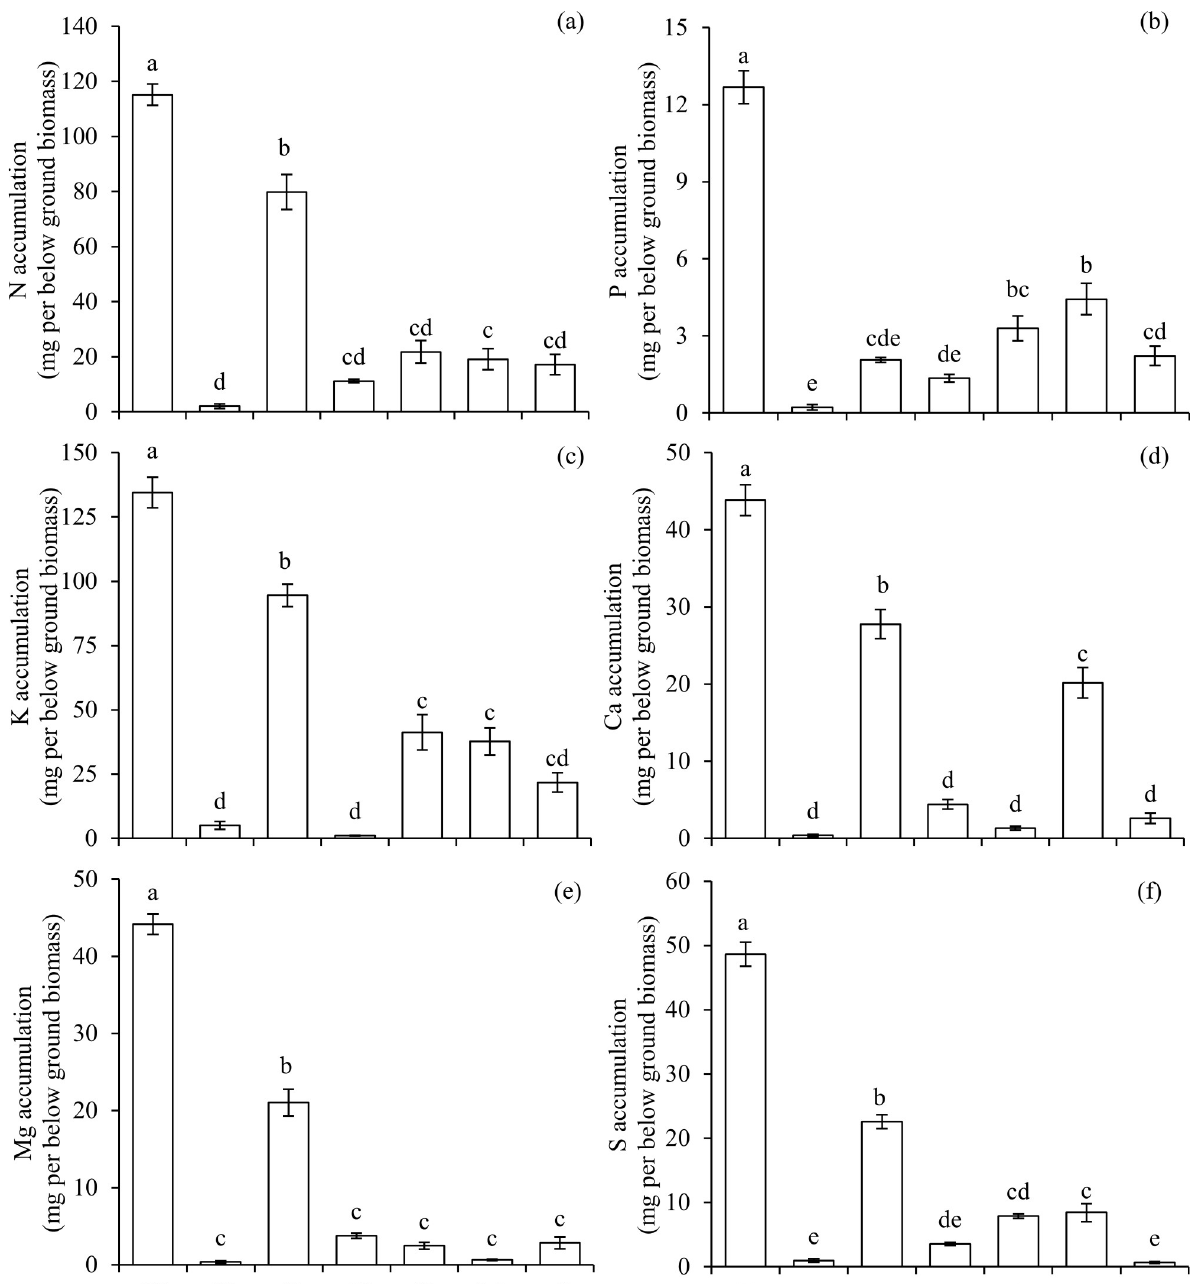
Fig 2. Accumulation of nitrogen (N) (a), phosphorus (P) (b), potassium (K) (c), calcium (Ca) (d), magnesium (Mg) (e), and sulphur (S) (f) in the below ground biomass of scarlet eggplants in complete solution (CS), and under the omission (-) of macronutrients ( − N, − P, − K, − Ca, − Mg, and − S). Means followed by the same letter in each bar did not differ from each other by the Tukey’s test (p � 0.05). Bars represent the standard error of the